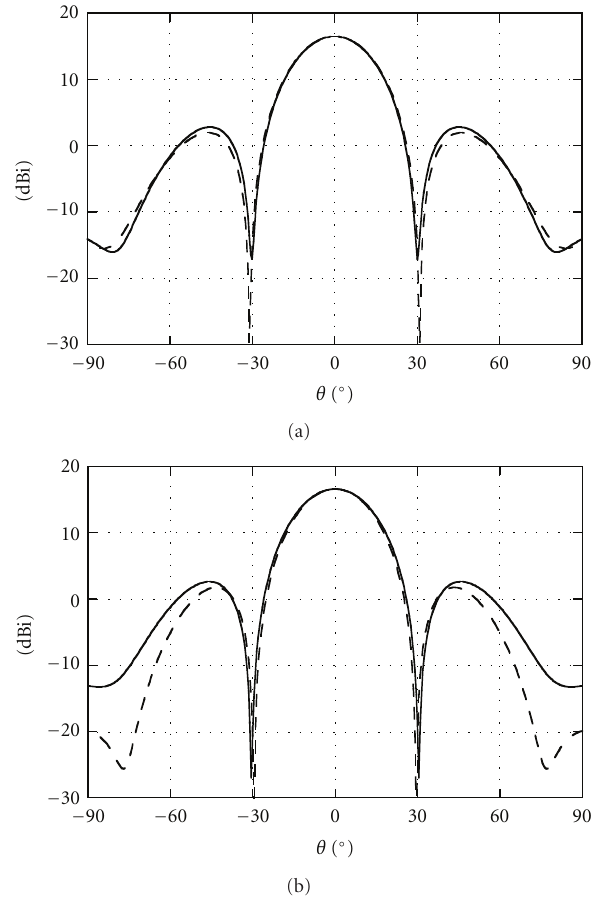
Figure 11: Array of 3 × 3 adjacent shielded cells as in Figure 2. Gain on the principal elevation planes φ = 0 ◦ ( solid lines ) and φ = 90 ◦ ( dashed lines ) at 5GHz. Beam pointing at broadside ( θ = 0 ◦ , all the cells are excited in phase). (a) The upper patches are fed. (b) The lower patches are